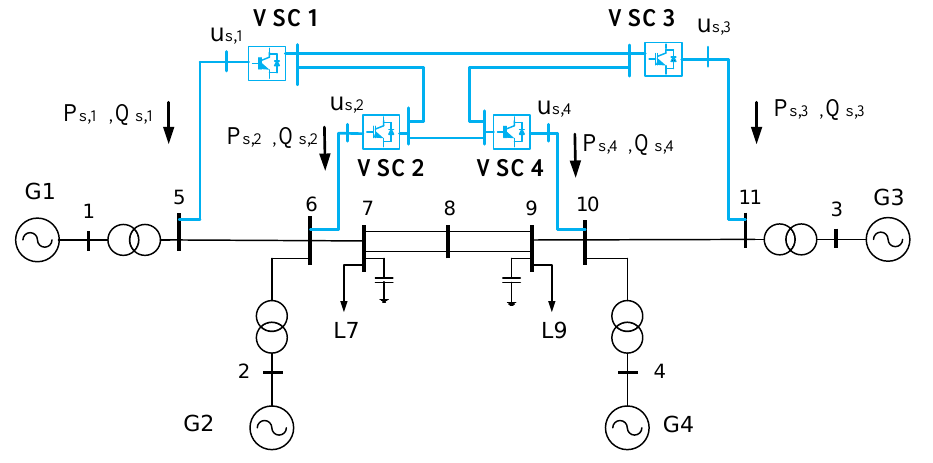
Figure 7. Kundur’s 2-area system with an embedded